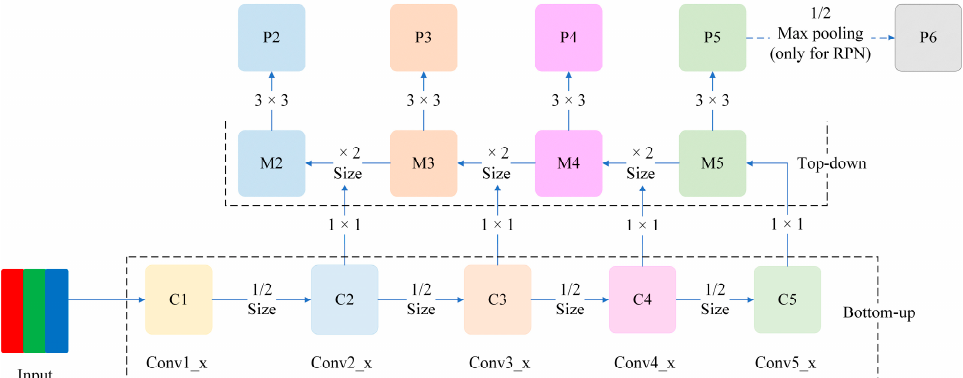
Figure 5. Schematic of the architecture that combines the feature pyramid network (FPN) and faster region-based convolutional neural network (Faster R-CNN).